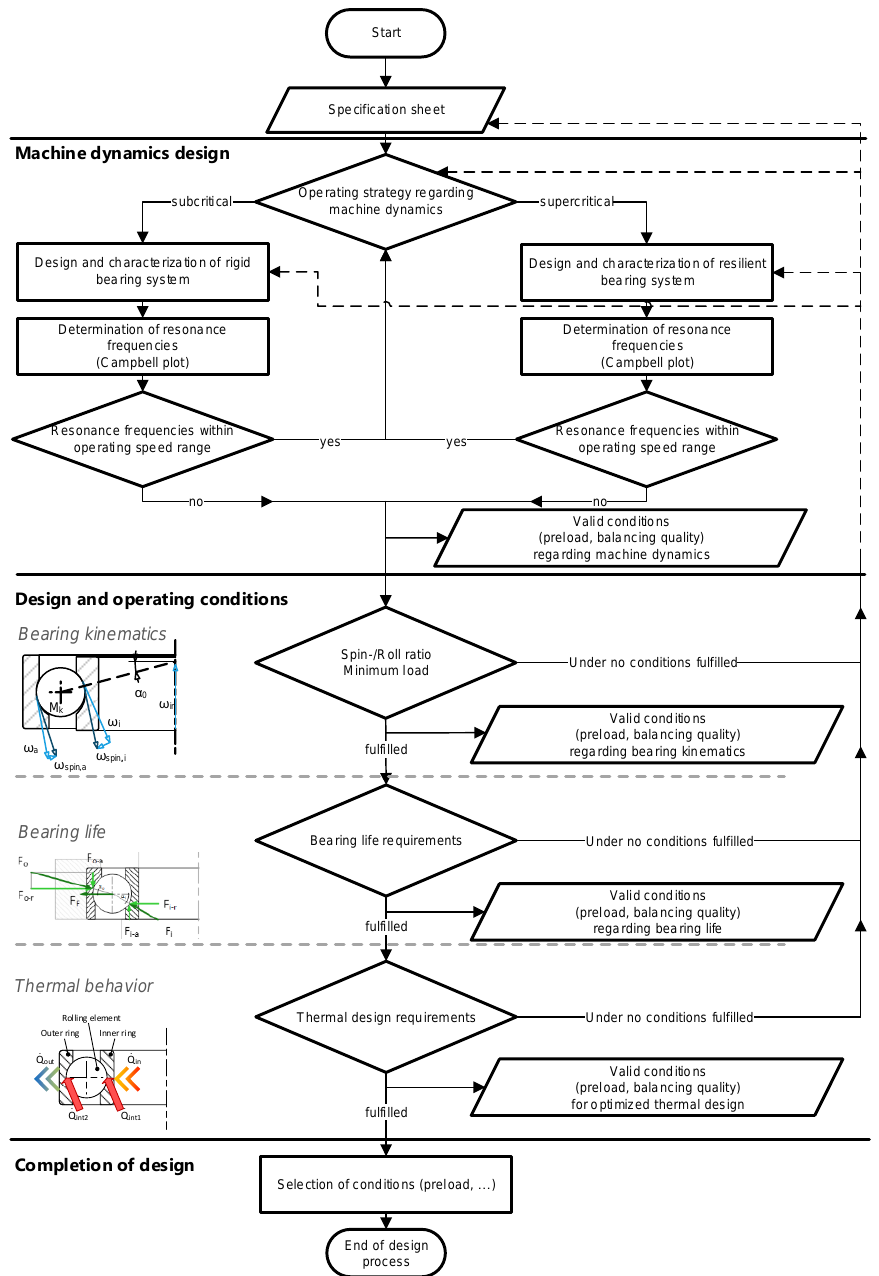
Figure 25. Flow chart illustrating the design guideline developed in this research.